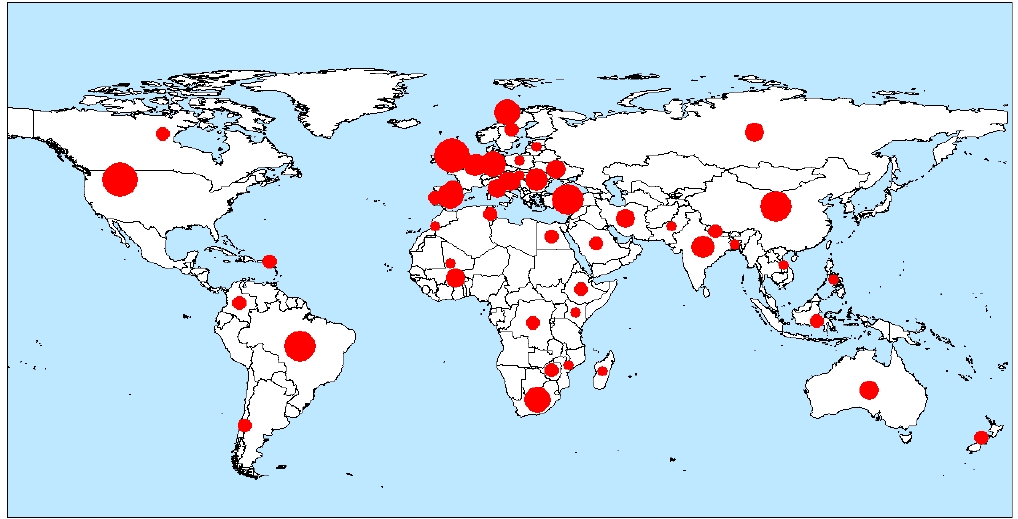
Figure 3. Representative distribution of the articles published on Sentinel ‐ 2 land cover mapping across the world.